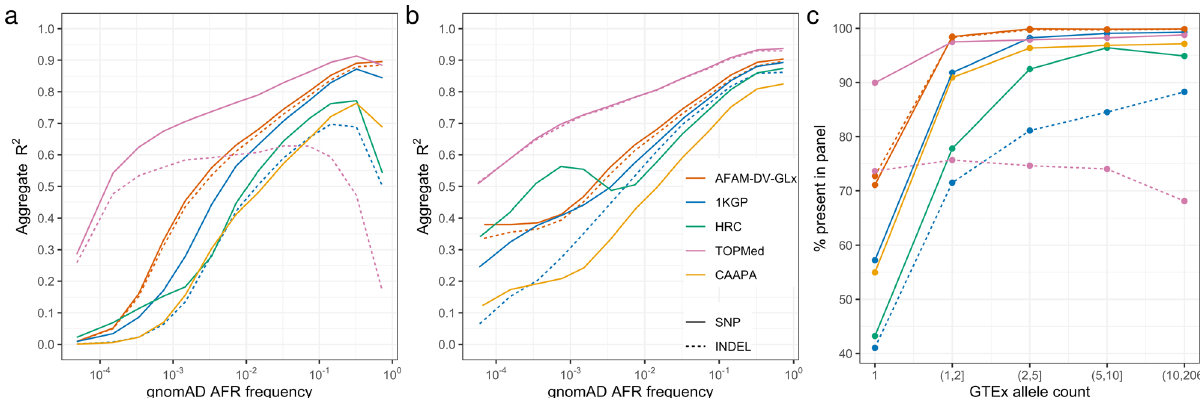
Fig. 4 Imputation performance for fi ve different panels using a truth set containing 103 GTEx WGS individuals imputed with an emulated 523 K 23andMe microarray. a Aggregate R 2 between the imputed dosages and sequence genotypes as a function of the alternate allele frequency reported for African Americans in the gnomAD r3 data set. We treat variants missing from the panel to be imputed as homozygous reference here, which penalizes panels that have missing variation. b Aggregate R 2 for variants only within a given panel (a more lenient measure than in a ). c The proportion of GTEx variants present at different allele counts in each panel. All panels have good sensitivity for SNPs with >2 copies of the allele in GTEx, whereas substantial numbers of indels appear missing from both TOPMed and 1KGP (HRC/CAAPA have no indels). The same legend is shared across all three fi gure